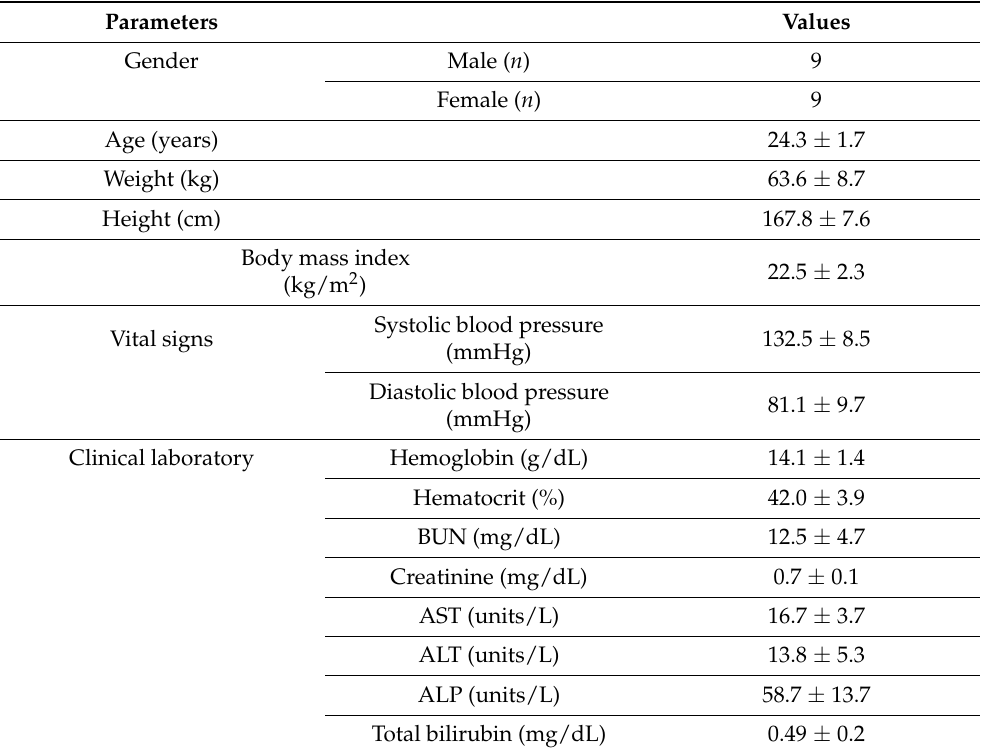
Table 1. General characteristics of enrolled